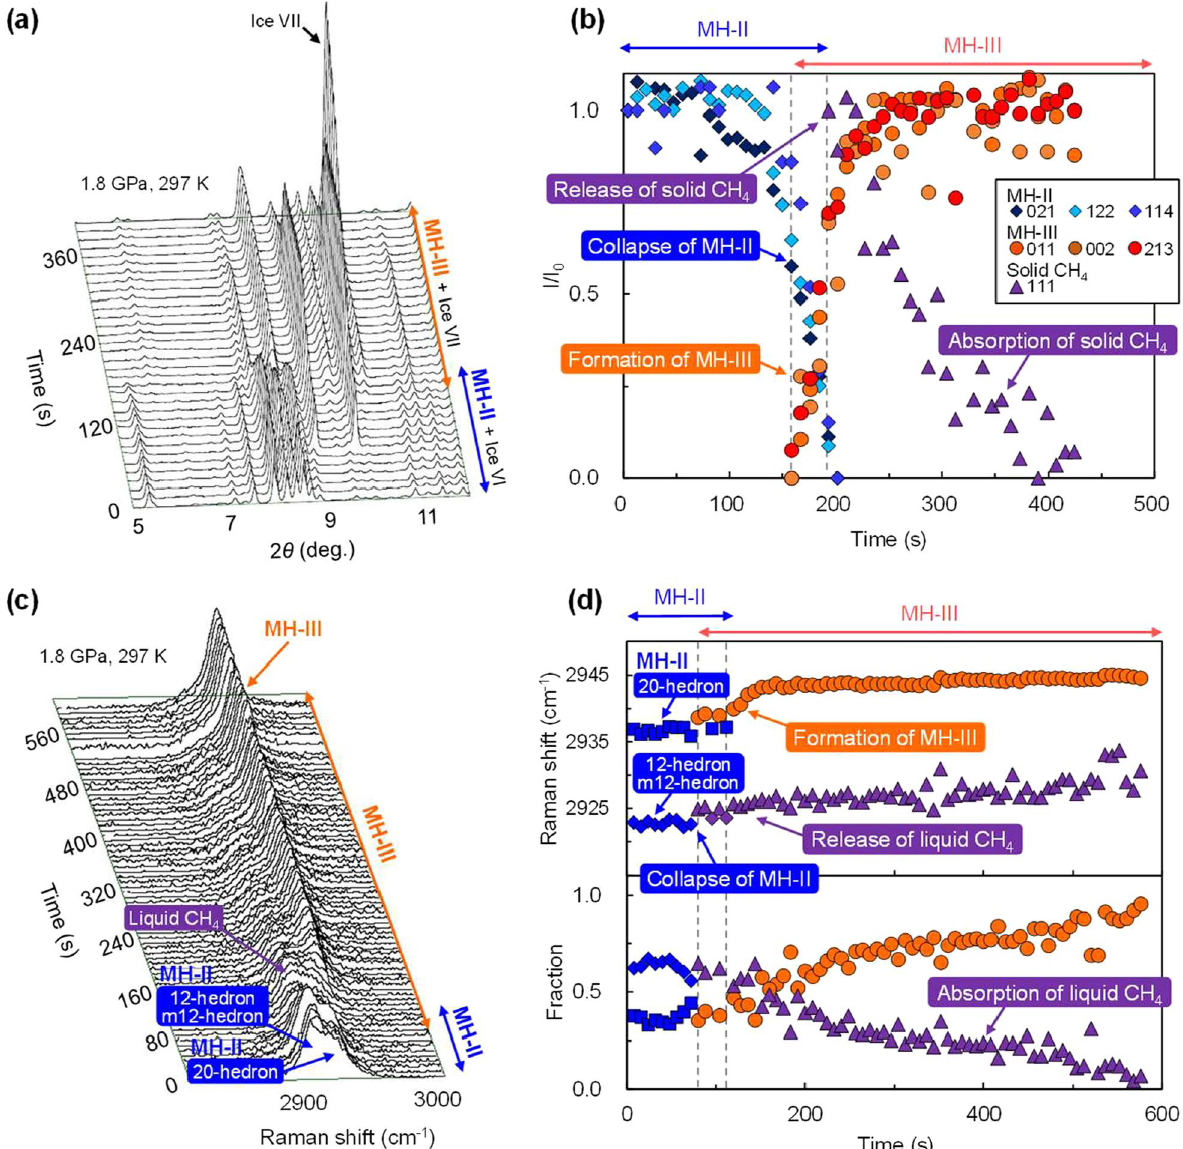
Fig. 3 Progression of phase change from MH-II to MH-III as described by changes in the host structures and vibrational modes of the guests over time. a Time-resolved XRD pattern and b relative intensity of the representative diffraction lines of MH-II and MH-III. c Time-resolved Raman spectra and d (top) Raman shift and (bottom) fraction of methane molecules in each cage of MH-II and MH-III and released liquid methane. The data show that MH-II collapses abruptly and that MH-III is reconstructed. This figure is modified from Hirai et al.